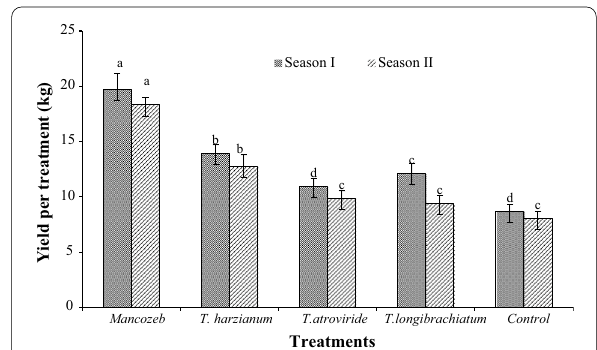
Fig. 6 Open field efficacy of Trichoderma bioagents on yield of tomato after natural infection of Alternaria solani in two different seasons. Values followed by different letters indicate that means are significantly different from one another, while values followed by same letter indicate no significant difference in means according to Fisher’s least significant difference at p 0.05. Error bars on graphs = represent the